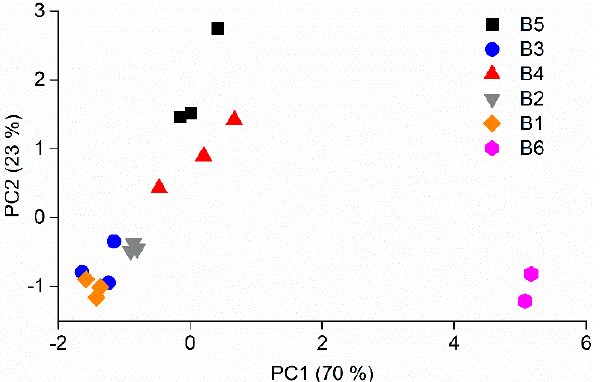
Figure 2. PCA for the six analyzed virgin olive oils during one measurement session. Each oil was measured in triplicate. measured in